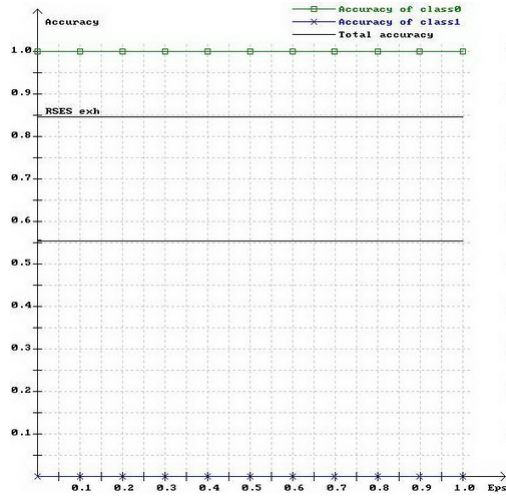
Fig. 9. Results for algorithm 7 v2, Best result for ε = 0, accuracy = 0.555073, coverage =